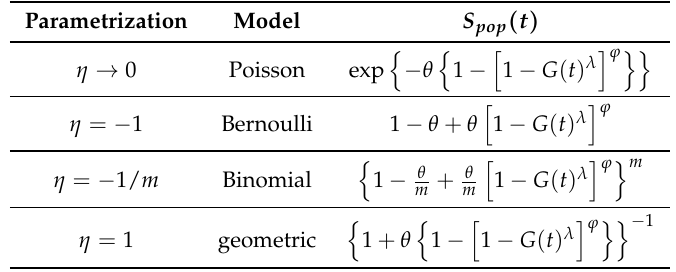
Table 2. S pop ( t ) , f pop ( t ) and the cured fraction for different distributions of N